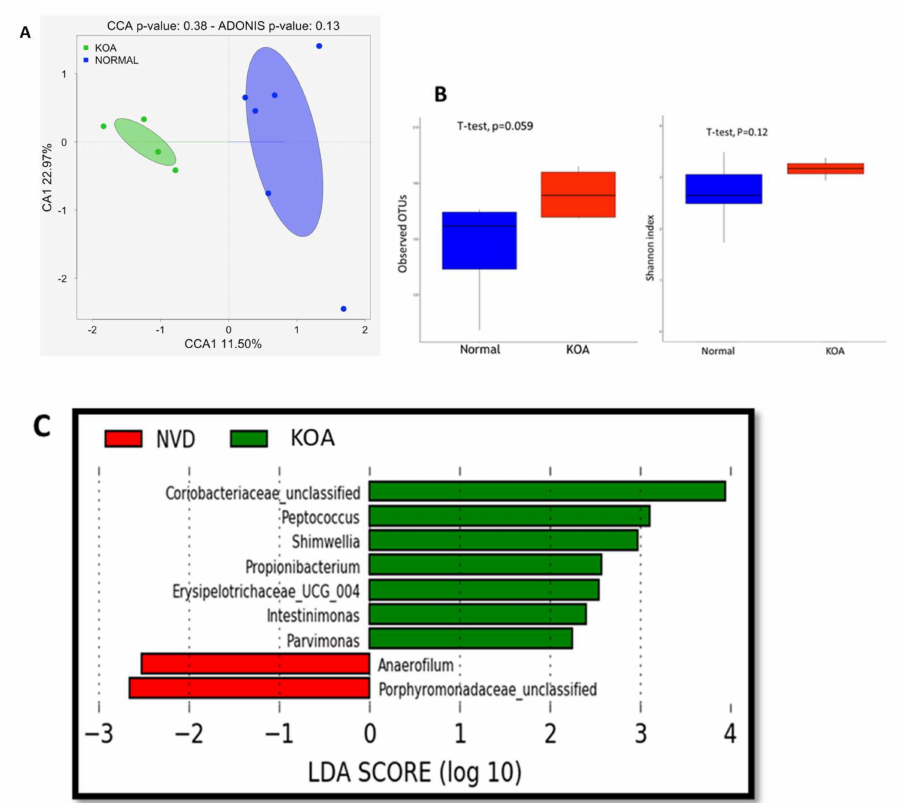
Figure 2. Knee osteoarthritis-associated dysbiosis: ( A ) canonical correspondence analysis (CCA) was performed to study the beta diversity between stool microbiome in KOA and Normal participants; ( B ) Alpha-diversity using the observed OTU and Shannon index based on Bray–Curtis distances; ( C ) A histogram of the log 10 transformed Linear discriminant analysis (LDA) scores was computed for features that showed differential abundance between healthy subjects and KOA